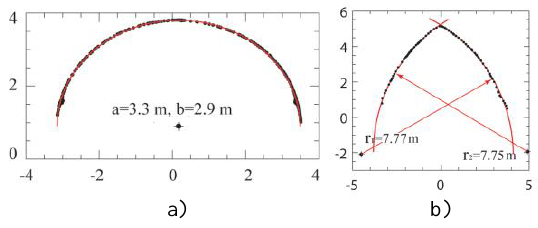
Figure 4. Shape identification in point-cloud by least square minimization procedures (Angjeliu et al., 2019a): a) arch in St.